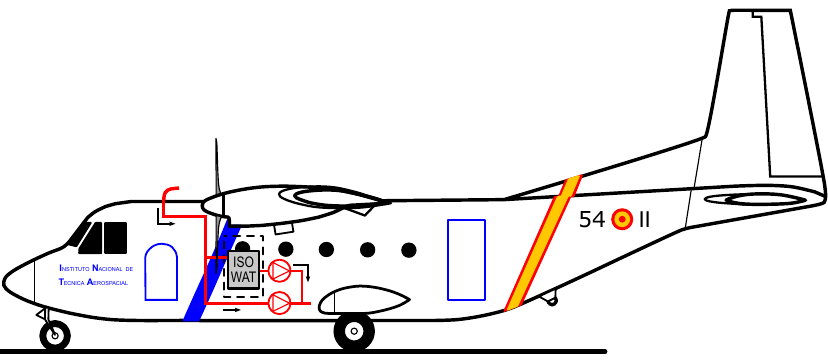
Figure 7. CASA C-212 aircraft of Instituto Nacional de Técnica Aerospacial (INTA). The rear-facing ambient air inlet was located on top of the fuselage. The inlet line was flushed at a high flow using a membrane pump. ISOWAT was mounted in the foremost position of the aircraft and was equipped with a second pump to establish the gas flow through the instrument.